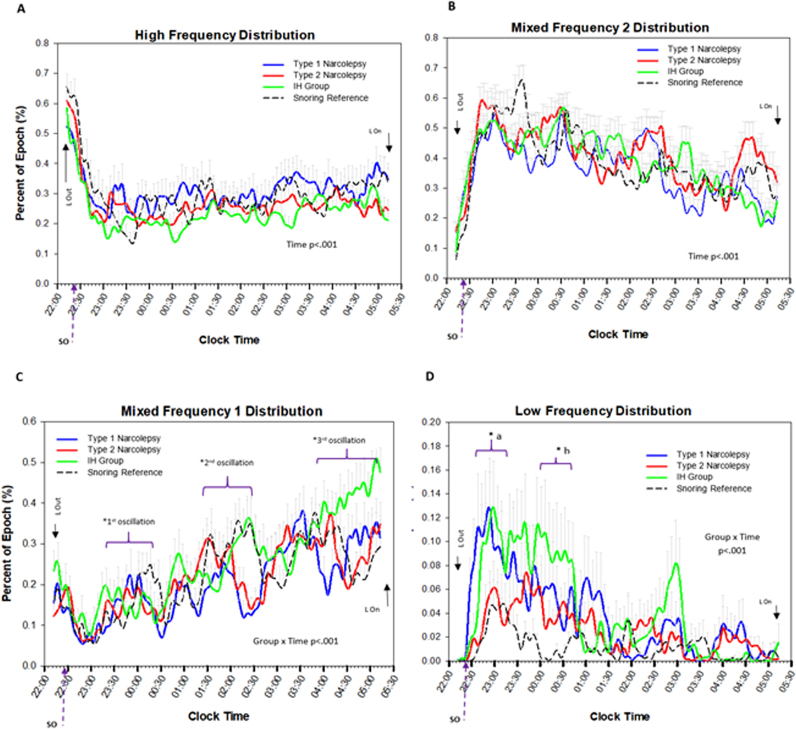
Time-related changes in percent of epoch comprised of each respective EEG frequency segment across time. HF = characteristic of wakefulness, MF2 = characteristic of stage 2, MF1 = characteristic of stage 1 and REM; LF = characteristics of stage 3. Each vertical tick on the X-axis represents a 5-minute time bin of the PSG (PSG = the first 7 h from Lights out; mean of 22:12 +/− 32 min). SO = mean sleep onset for all groups (no statistical differences between groups). Trend lines represent spline-smoothed changes in mean percent of time comprised of each frequency component over time. Bars represent standard error bars (SEM). Mixed model ANOVA with Bonferroni post-hoc comparison to assess group (N = 4) by time (N = 82 time increments) changes. 2 A&B-main effect of time observed, no interaction or group effects. 2C- group by time interaction (p < 0.001); 1st oscillation- early in N-1, N-2 & IH compared to snoring controls p < .05), 2nd oscillation- N-1 & N-2 early vs. IH & snoring reference (p < 0.05); 3rd oscillation- N-1 & N-2 early vs. IH & snoring reference (p < 0.05). 2d- group by time interaction (p < 0.001); *a = N-1 & IH high LF domains than N-2 & snoring reference at acrophase (p < 0.05); *b = IH higher LF domains than all others (p < 0.05); precipitously decreasing at 1:00.